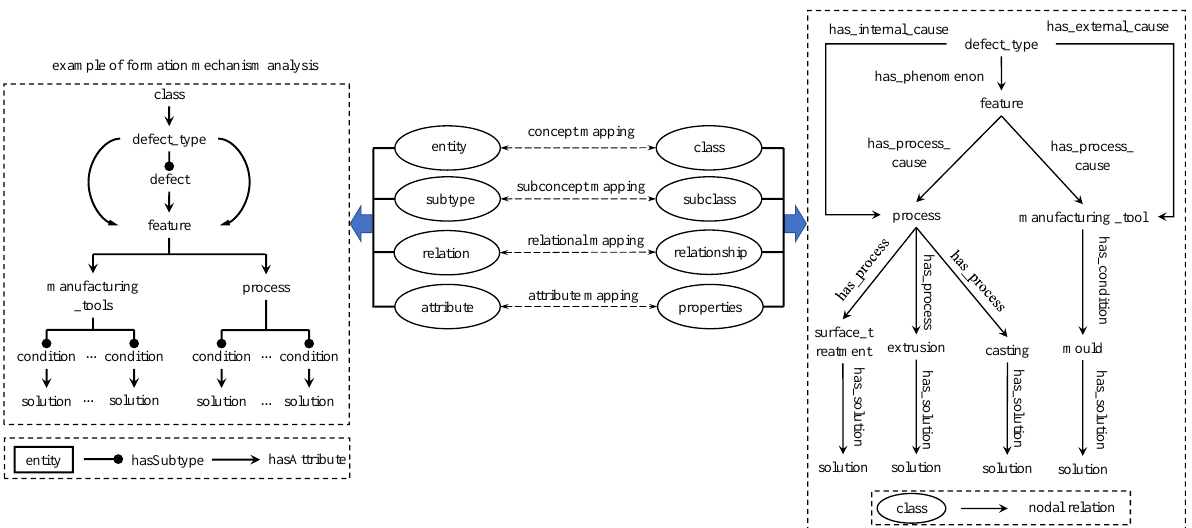
Figure 13. Mapping relationship between surface defect formation mechanism analysis and corre- sponding ontology.